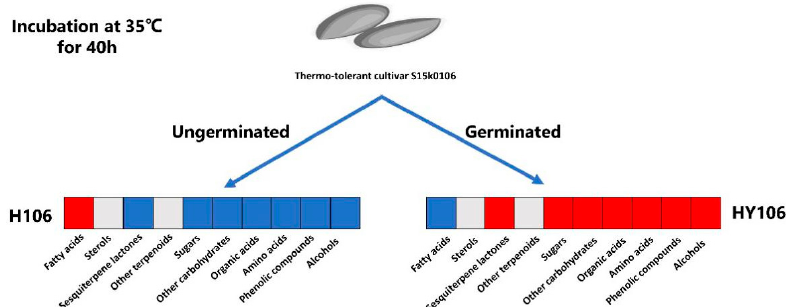
Table 4. Differential metabolites between buds of S15k0106 germinated at 35 °C (HY106) and seeds of S15k0106 that did not germinate at 35 °C (H106).